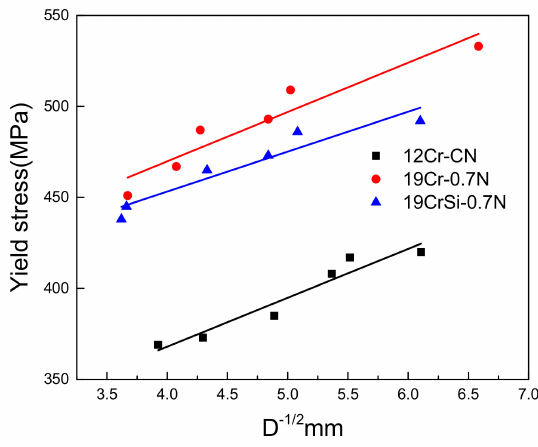
Figure 3. Hall–Petch fitting relationship. The Hall–Petch relationship for the yield strength had a similar slope in Figure 3. The recrystallized grains and the intracrystalline annealing twin boundary or original austenite boundary hinder the dislocation movement to achieve the grain boundary strengthening effect, which can be achieved through σ y ,recrystallized = σ 0 + σ g indicates. By fitting the